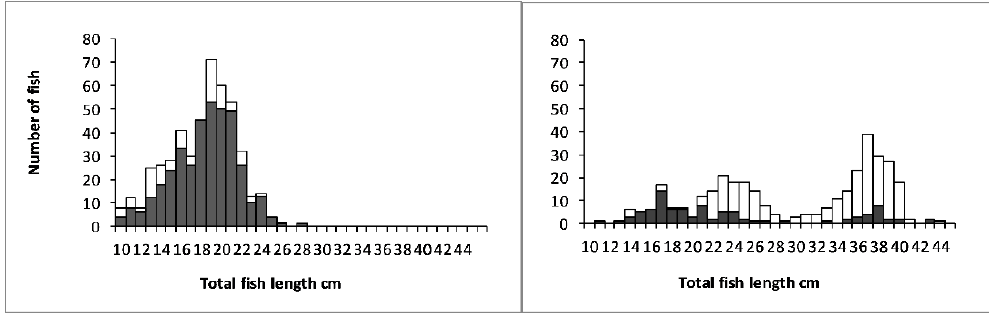
Figure 4. ( left ): Total length frequency distribution of smelt and ( right ): whitefish caught in benthic nets (filled columns) and pelagic nets (open columns)